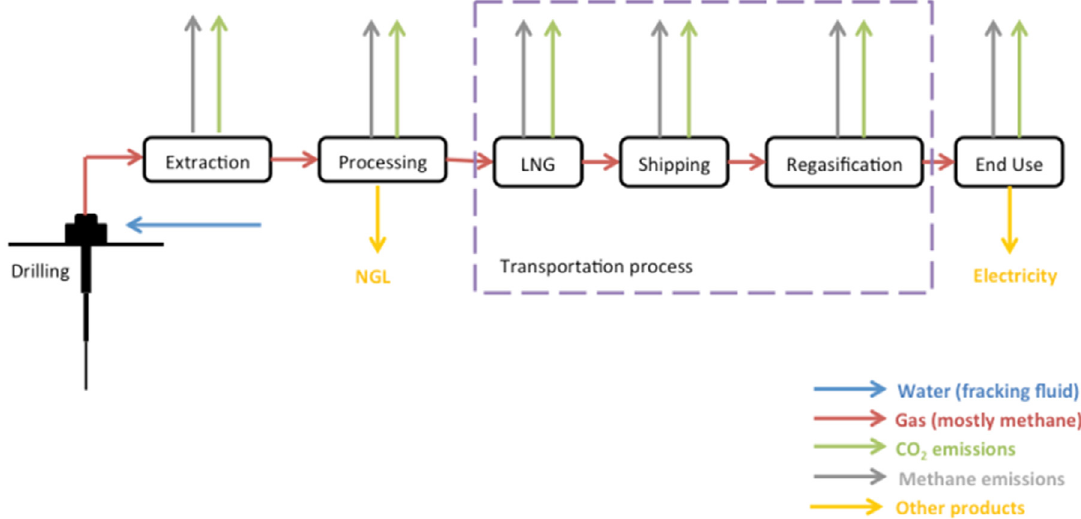
Fig. 1. Study boundary for LCA analysis of hydraulic